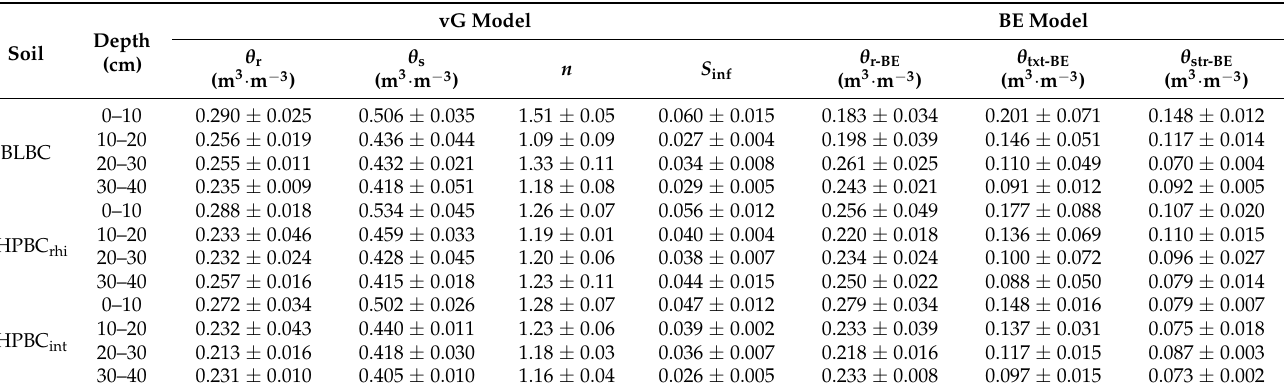
Table 4. Fitted soil water retention parameters (mean ± std.) by using vG and BE model in plots BLBC and